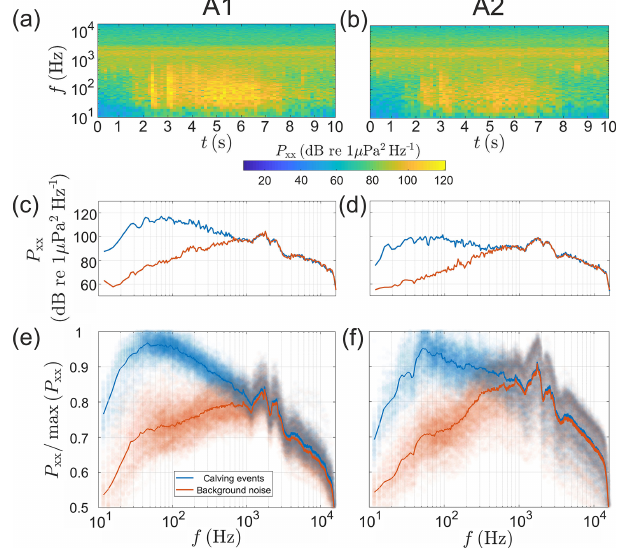
Figure 6. (a–b) Spectrograms of the acoustic signal generated by the calving event recorded at A1 (a, c, e) and A2 (b, d, f) , (c–d) cor- responding time-averaged spectra of background (red) and calving (blue) noise, and (e–f) normalized power spectral densities for the entire calving inventory. The calving event for which spectrograms and spectra are shown in panels (a) – (d) started on 30 August 2016 at 08:11:08UTC. A difference of 10, 20 and 40dB in P xx corre- sponds, respectively, to a factor of 10, 100 and 10000 in acoustic energy. Noise spectra were normalized using maximum values of the calving signal for each event. Solid lines in (e) – (f) show median normalized